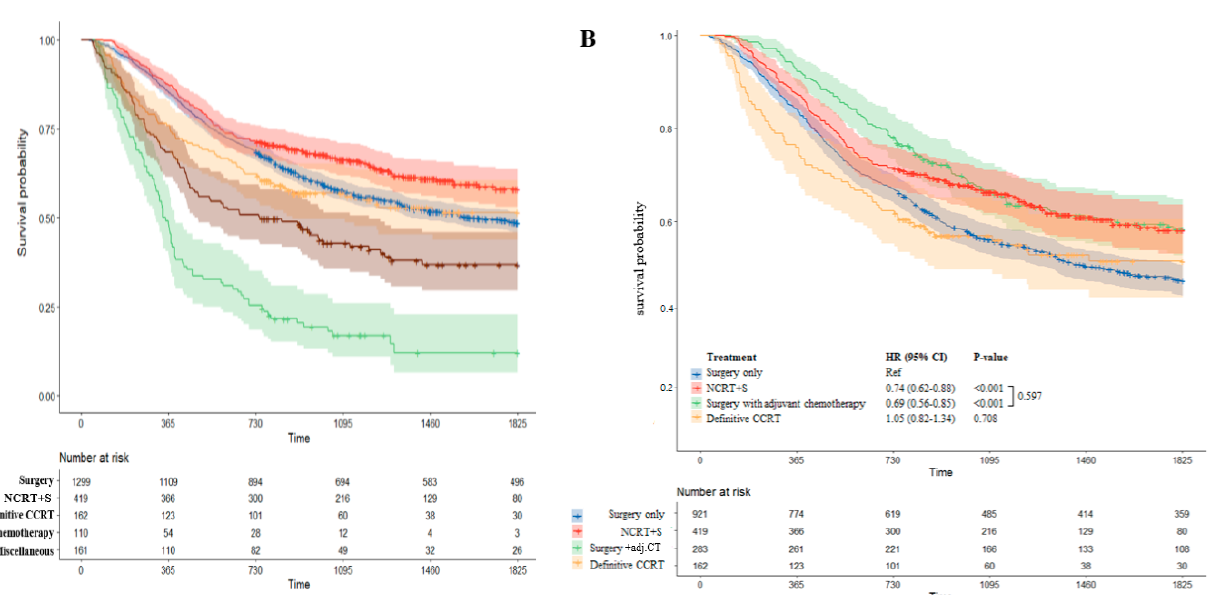
Figure 4. Comparison of Kaplan–Meier survival curve by treatment period.